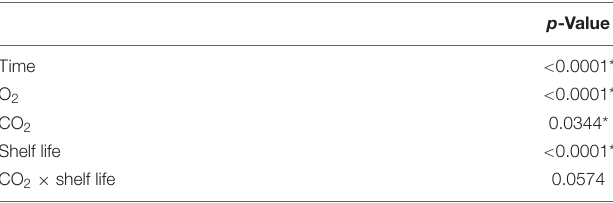
TABLE 1 | Results of the ordinal logistic regression carried out on the leaf score data presented in Figure 3 .